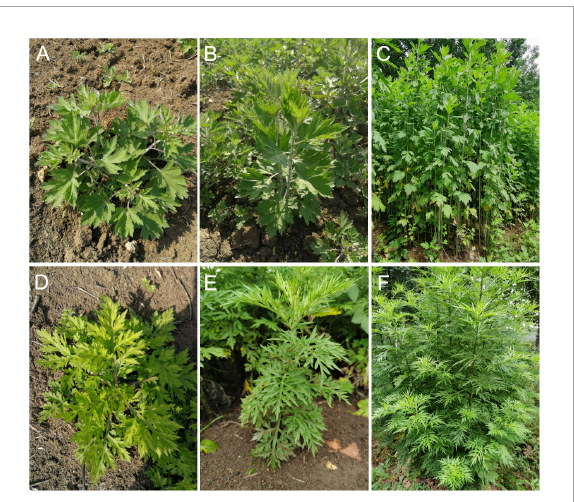
FIGURE1 Morphological characteristics of A. argyi and A. indica . A. argyi (A–C) and A. indica (D–F) at three different growth stages (April, May, and